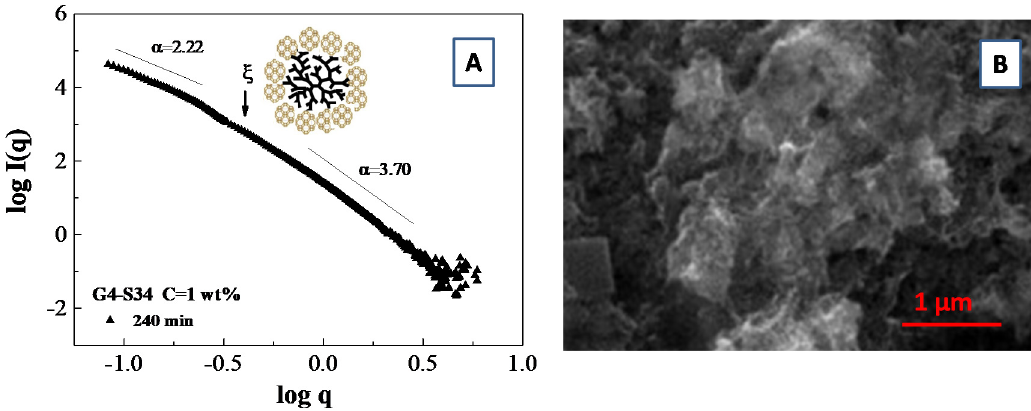
Figure 9. SAXS fractal analysis for a system of Silicoaluminophosphate SAPO-34 zeolite nanoparticle on template of polyamidoamine (PAMAM) dendrimer (generation G = 4.0) at the water concentration of C = 1 wt.%. The log–log plot of the SAXS intensity profile during the late stages of SAPO-34 zeolite synthesis identify the linear regions for the fractal analysis ( A ). Scanning electron microscopy (SEM) images of the aggregates generated during dendrimer template directed SAPO-34 zeolite synthesis ( B ).